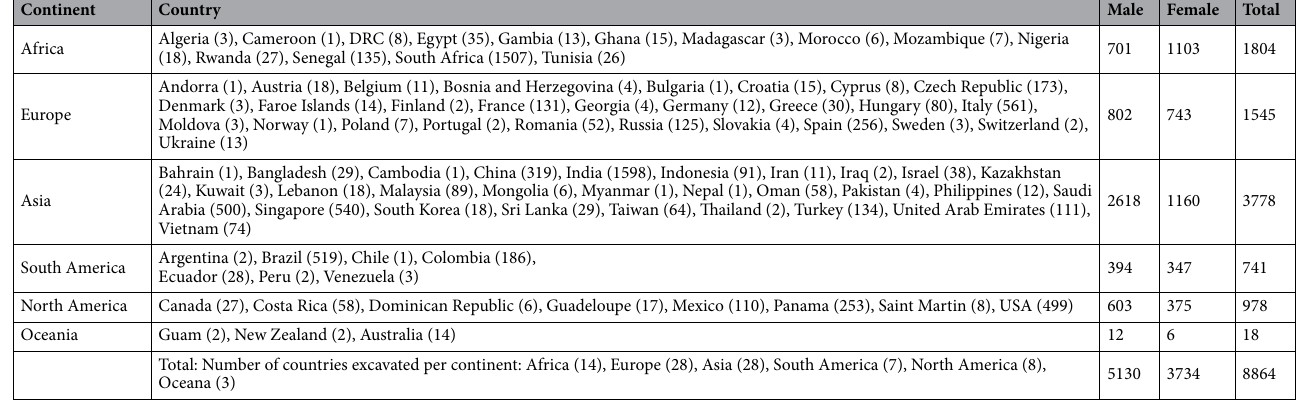
Table 9. Distribution of excavated